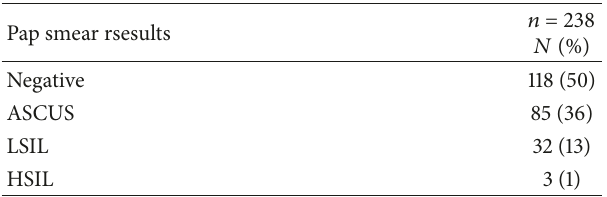
Table3:ResultsofallPapsmearsresultsforHIV+women > 65years